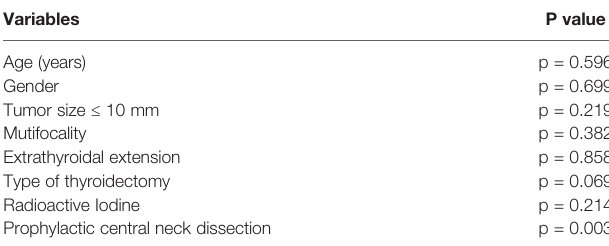
TABLE 3 | Univariate analysis of risk factors for recurrence in pediatric patients. Variables